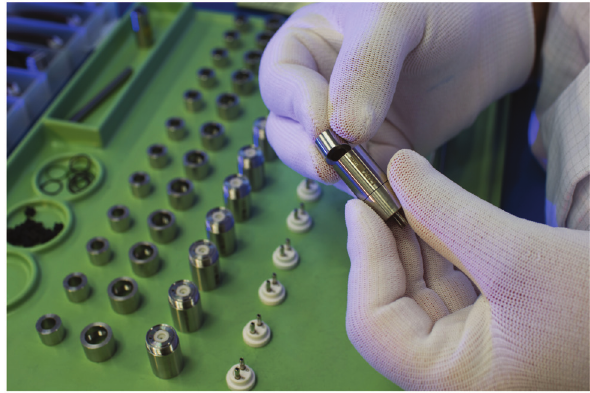
Figure 2 Assembly of the smallest annular gear pump of the world.